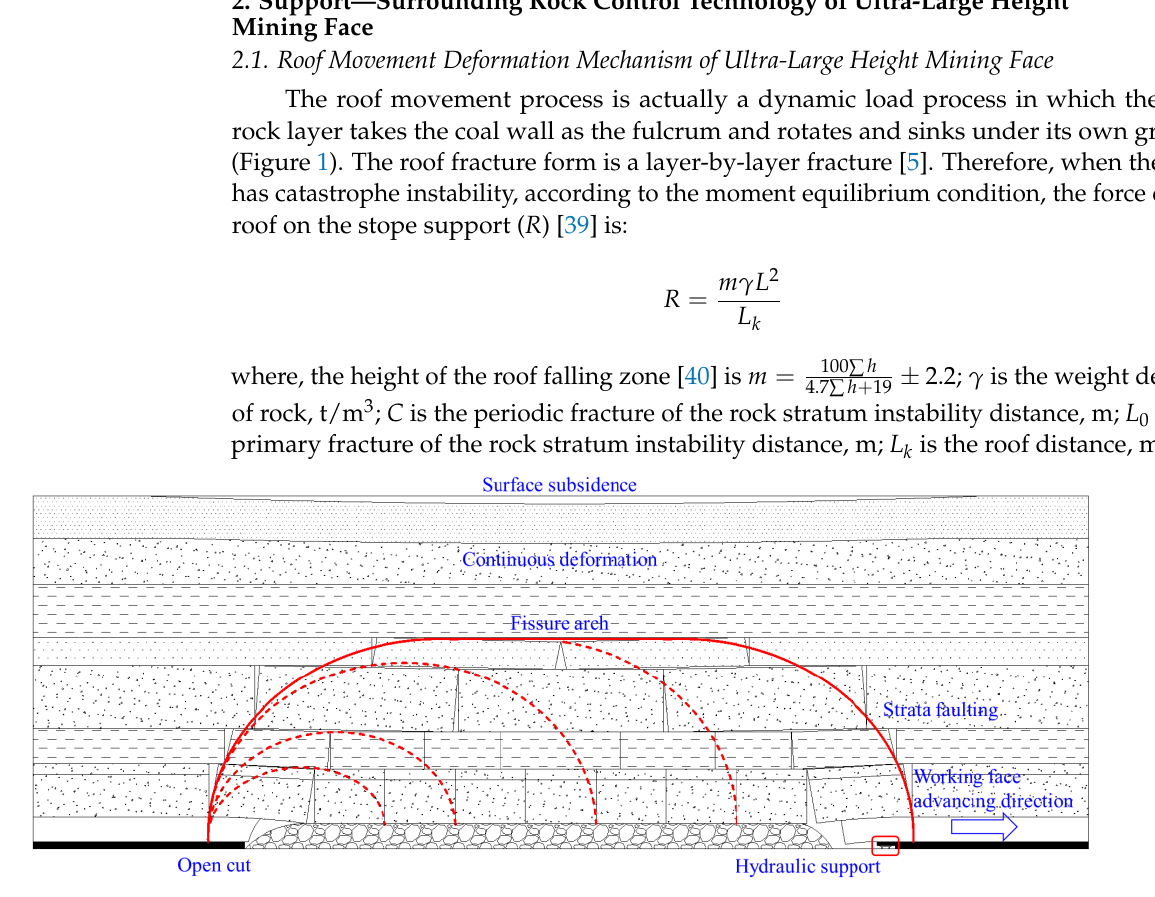
Figure 1. Mechanical model diagram of roof effect on stope supports.